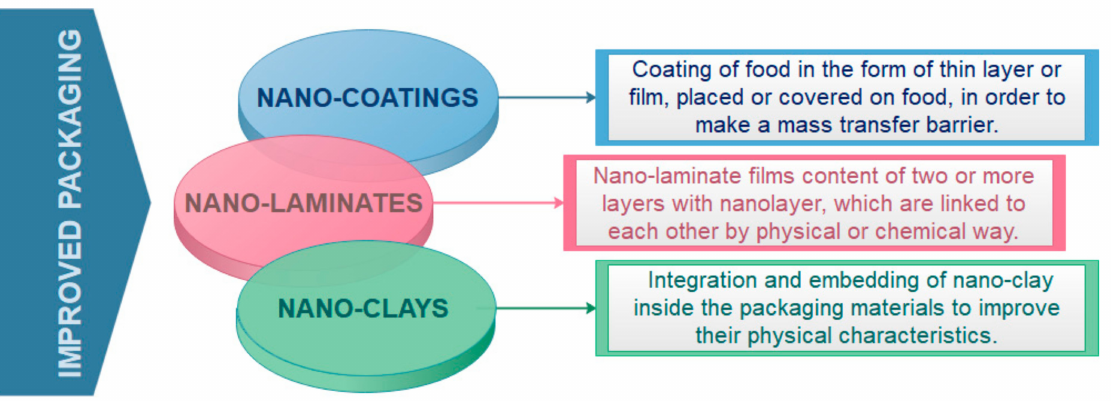
Figure 3. Nanotechnology methods for improvement of mechanical and physical properties of food